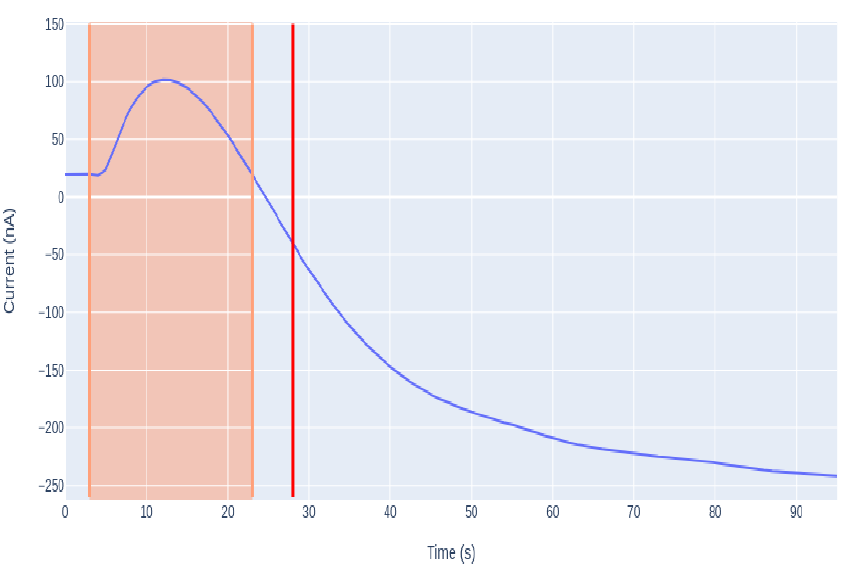
Figure 14. Graphical representation of the signal with the calculation of the point at which the derivative is minimum.